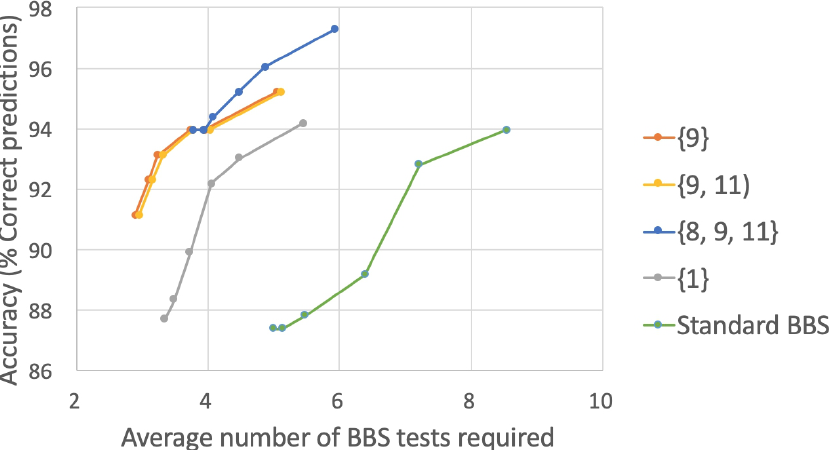
Figure 9. Accuracy vs. average number of BBS tests for the different initial subset of tasks. Results are shown for Selector Method 3 and training on the physiotherapists’ data. For each initial subset of the tasks, the plot shows values for 6 different confidence thresholds (90, 92, 94, 96, 98, and